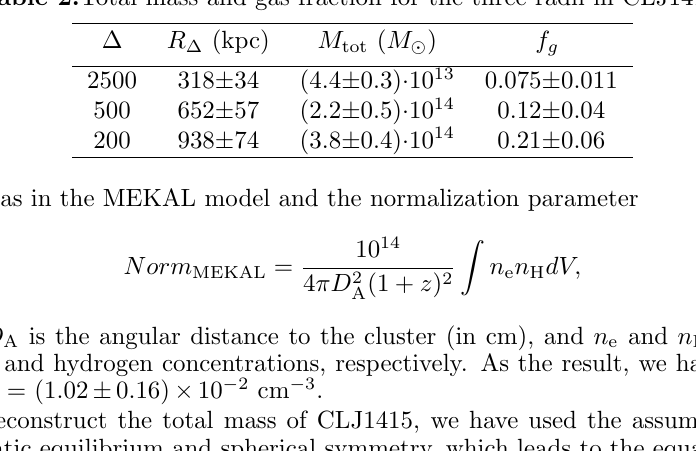
Fig. 4. The surface brightness pro(cid:12)le in the energy range 0.5{7.0 keV and the best-(cid:12)t (cid:12) -model for CLJ1415. Table 2. Total mass and gas fraction for the three radii in